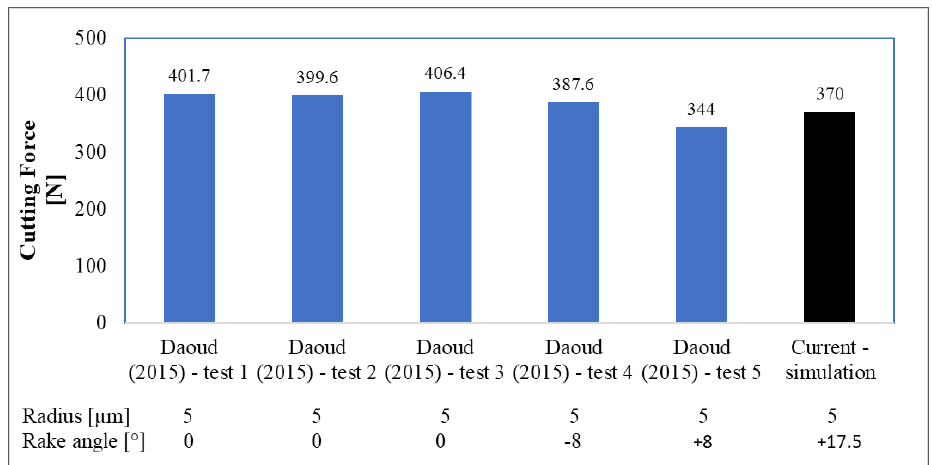
Figure 26. Comparison of simulated cutting forces and experimental cutting forces [33].